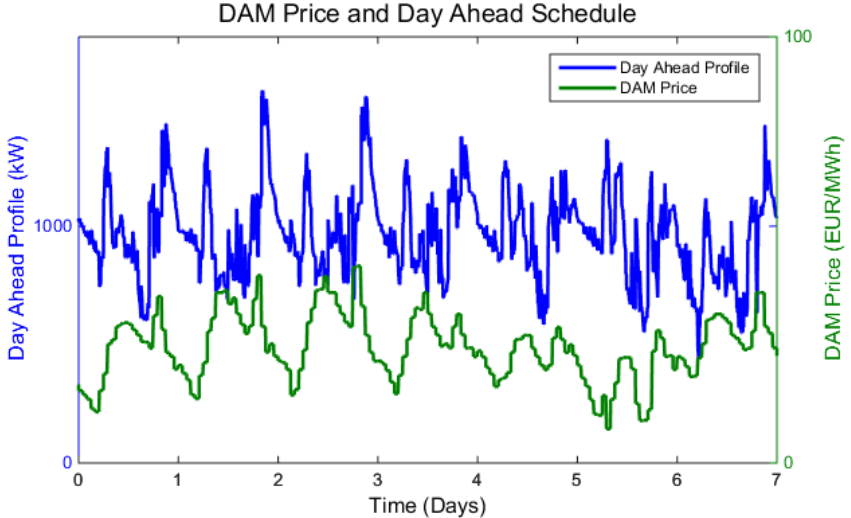
Figure 5. DAM price with associated day ahead schedule of 1000 households for one